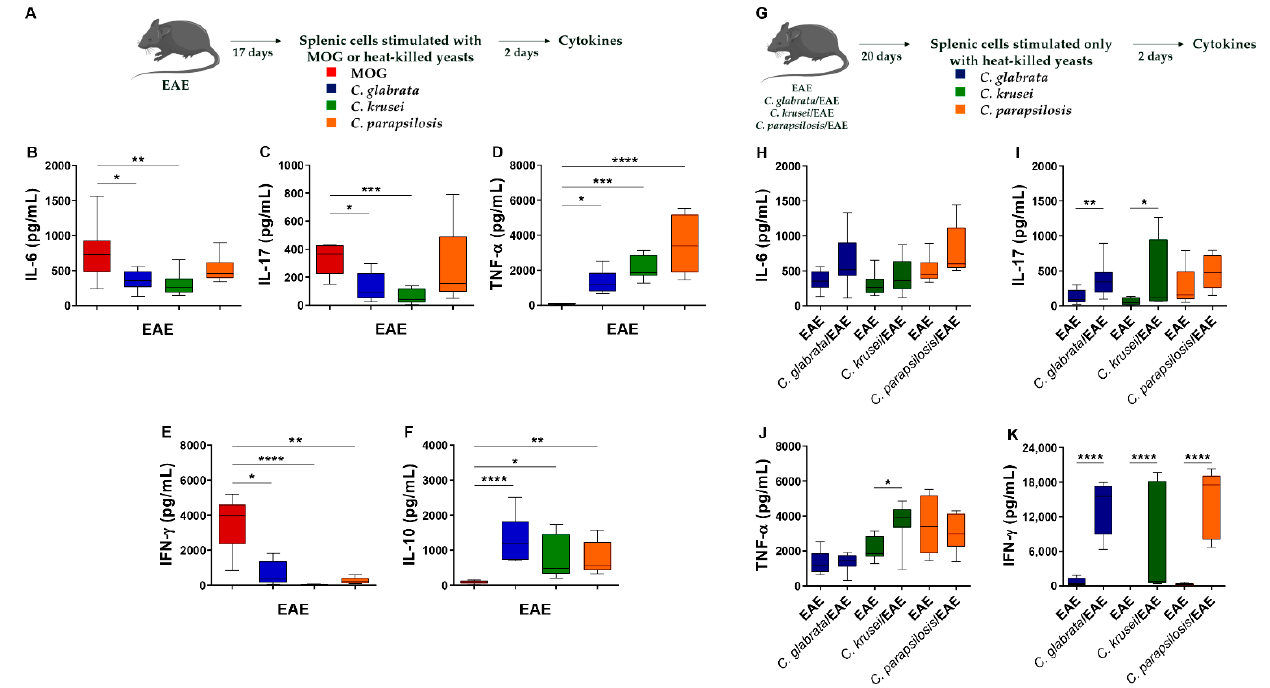
Figure 5. Effect of non- albicans Candida infection in the systemic immune response of EAE mice. Splenic cells (5 × 10 6 cells / mL) derived from non-infected EAE mice were stimulated with MOG (20 µg/mL) or with non- albicans Candida heat-killed yeasts (1 cell: 5 yeasts) for 48 h ( A ). IL-6 ( B ), IL-17 ( C ), TNF- α ( D ), IFN- γ ( E ), and IL-10 ( F ) levels were quantified in cell-free supernatants. Splenic cells (5 × 10 6 cell / mL) derived from non-infected and infected EAE mice were stimulated with non- albicans Candida heat-killed yeasts (1 cell: 5 yeasts) for 48 h ( G ). IL-6 ( H ), IL-17 ( I ), TNF- α ( J ), and IFN- γ ( K ) levels were quantified in cell-free supernatants. The results are expressed as box ± min to max from three independent experiments (n = 8–13/group) and * p < 0.05, ** p < 0.01, *** p < 0.001, and **** p < 0.0001.